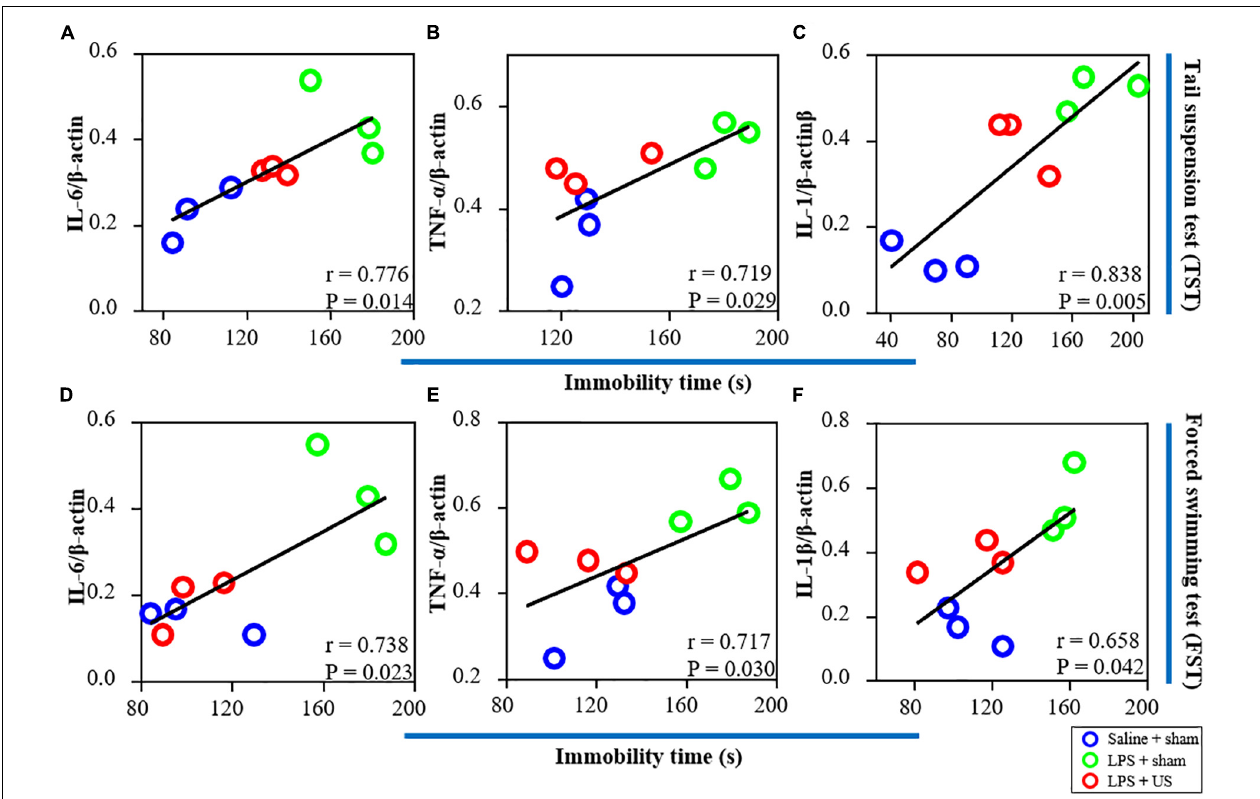
FIGURE 6 | Correlations between inflammatory factors in the PFC (the results from western blot) and behavioral performance. (A) There is a positive correlation between the expression of IL-6 in the PFC and immobility time in the TST. The expression of TNF- α (B) and IL-1 β (C) is positively correlated with immobility time in the TST. (D) There is a significant correlation between the expression of IL-6 in the PFC and immobility time in the FST. The expression of TNF- α (E) and IL-1 β (F) is positively correlated with immobility time in the FST ( n = 3 in each group). PFC, prefrontal cortex; US, ultrasound stimulation; LPS, lipopolysaccharide; FST, forced swimming test; TST, tail suspension test.